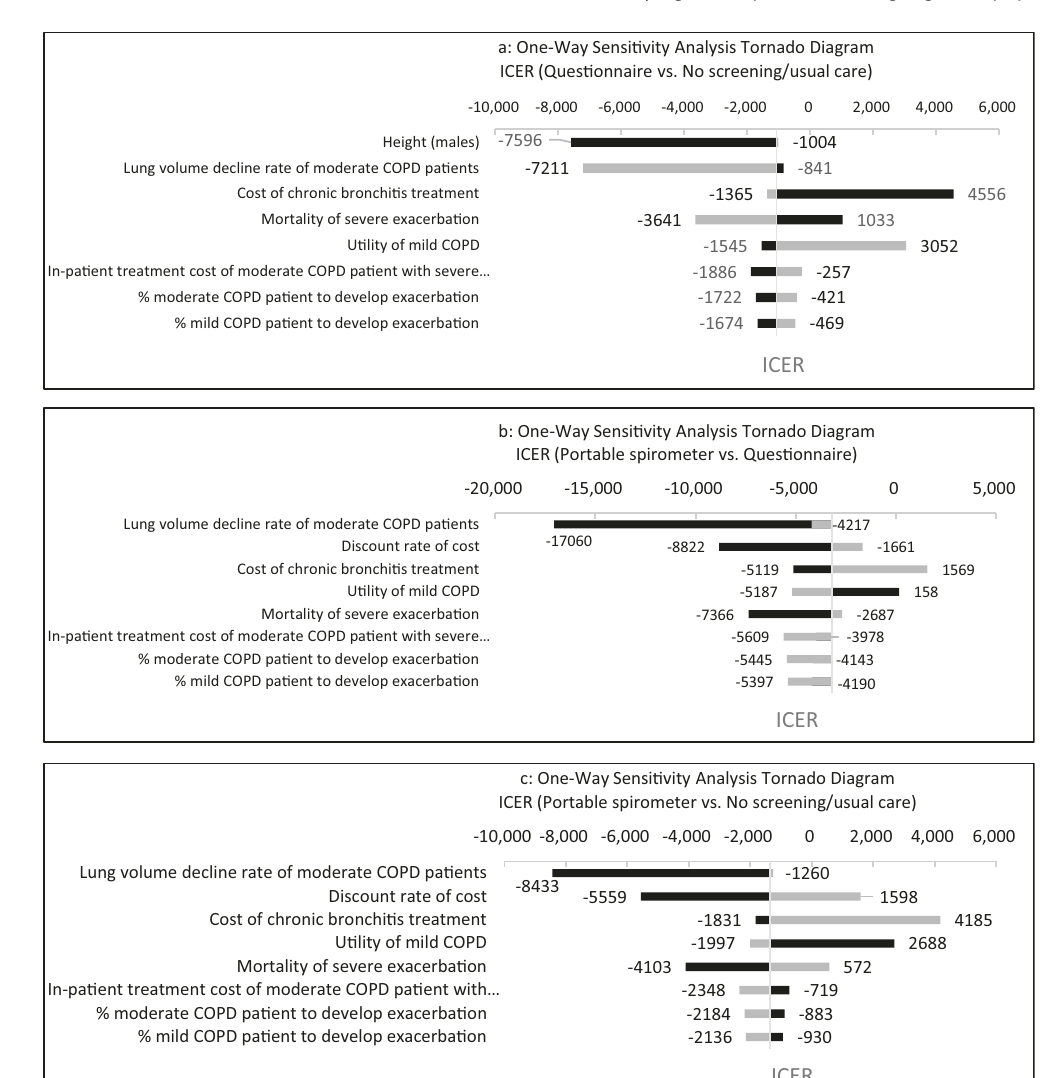
Fig. 1 Tornado diagram of one-way sensitivity analysis. Light gray bar represented the lower limit, while dark gray line represented the higher limit of the parameter